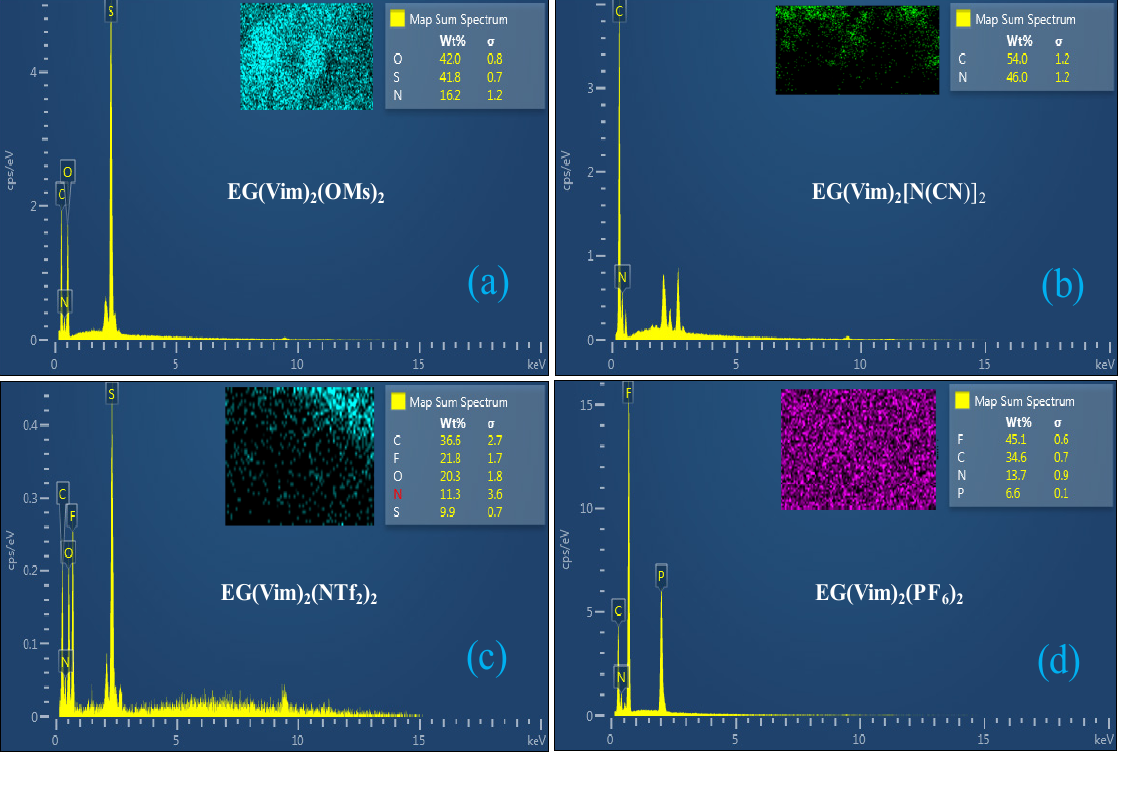
Figure 5: Elemental analysis of synthesized RTILs.